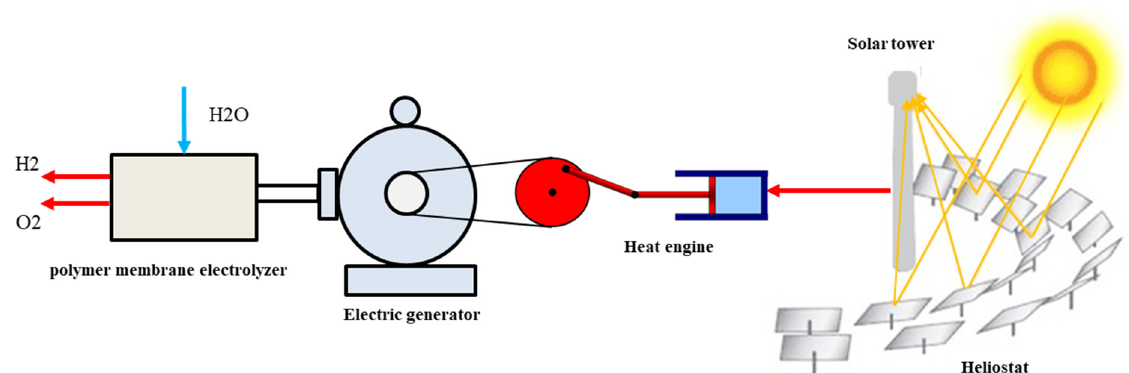
Figure 1. Schematic view of the system investigated in this article.